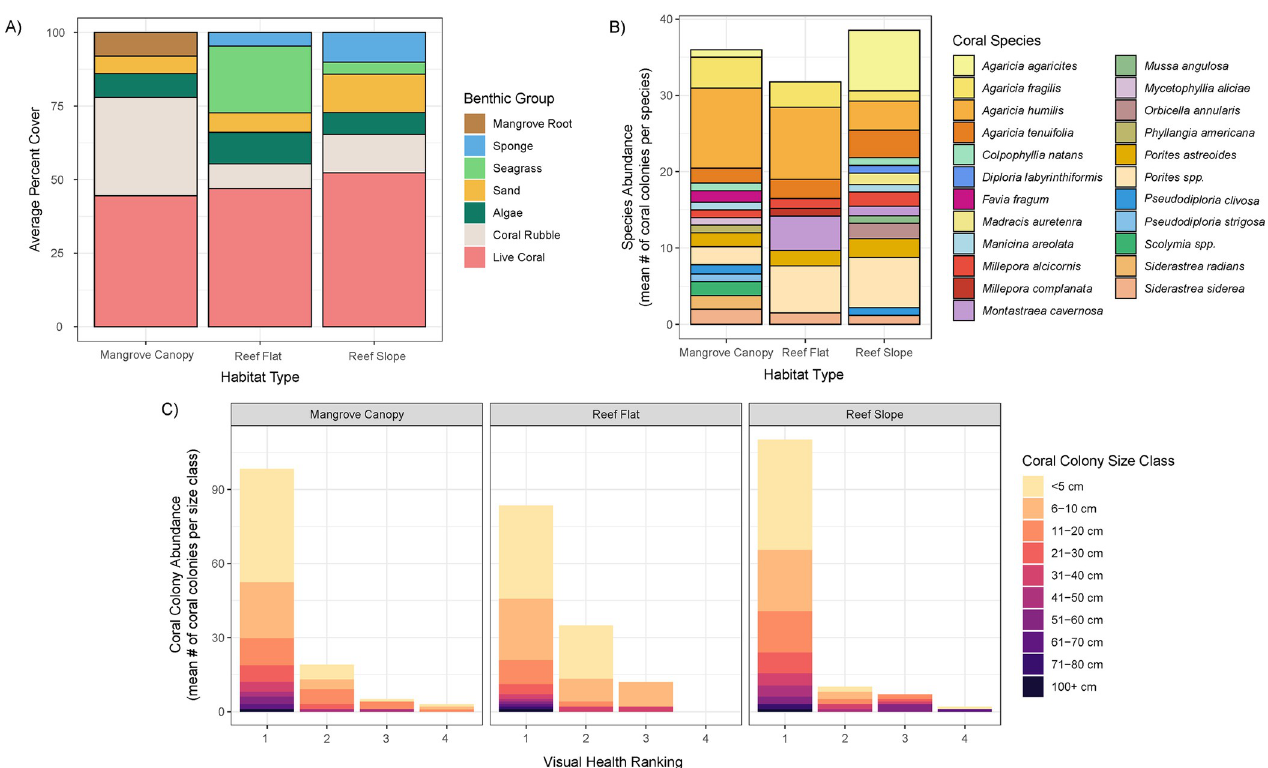
Fig 3. Coral community composition among coral habitats. (A) Average benthic percent cover of 12 replicate quadrats within three different coral habitats (mangrove, adjacent reef flat, and reef slope). There was no significant difference in the percent cover of live coral between habitats, but there was a significant difference in the percent cover of coral rubble with mangroves having 3x the amount of coral rubble of either reef habitat. (B) Average abundance of coral colonies by coral species among coral habitats. Porites divaricata , P . furcata , and P . porites are combined under Porites spp. (C) Average abundance of coral colonies by coral colony size class and visual health ranking (1 = visibly healthy, 2 = mild bleaching/tissue loss, 3 = moderate bleaching/tissue loss, 4 = severe bleaching/tissue loss) among coral habitats.